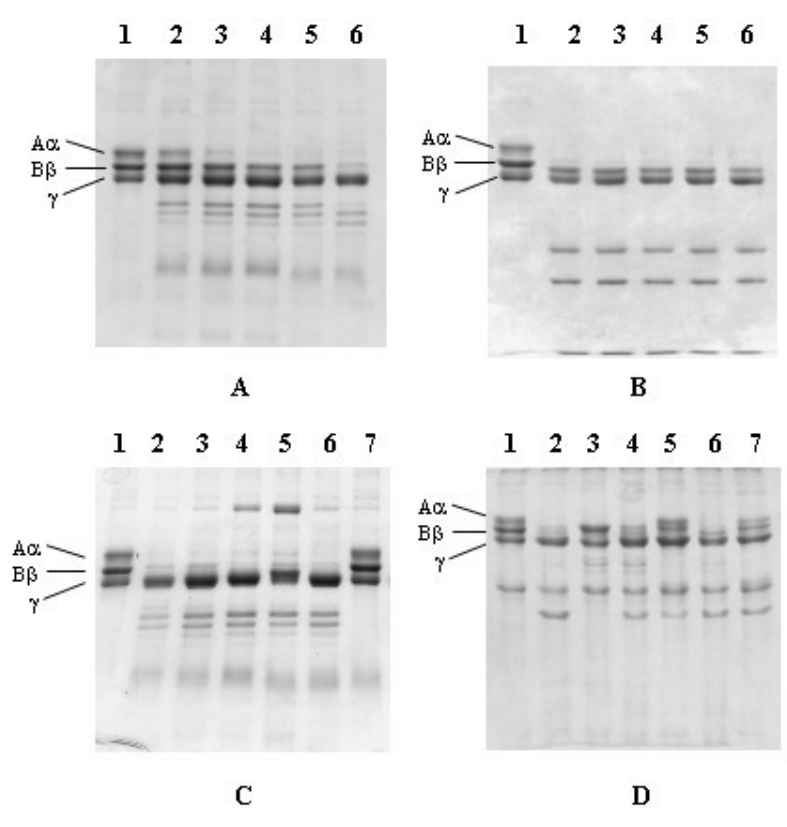
Figure 3. Proteolysis of fibrinogen by BaltMP-I and II. (A) and (B): Lane 1: control fibrinogen incubated without enzyme for 60 min; Lanes 2, 3, 4, 5, and 6 : fibrinogen incubated with BaltMP-I and II for 15, 30, 45, 60 and 90 min, respectively. (C) and (D): Lane 1: control fibrinogen incubated without enzyme for 60 min; Lane 2: control fibrinogen incubated with enzyme for 60 min; Lanes 3, 4, 5, 6 and 7: fibrinogen after incubation with BaltMP-I or II + PMSF, aprotinin, EDTA, β -mercaptoethanol and 1,10-phenanthroline,